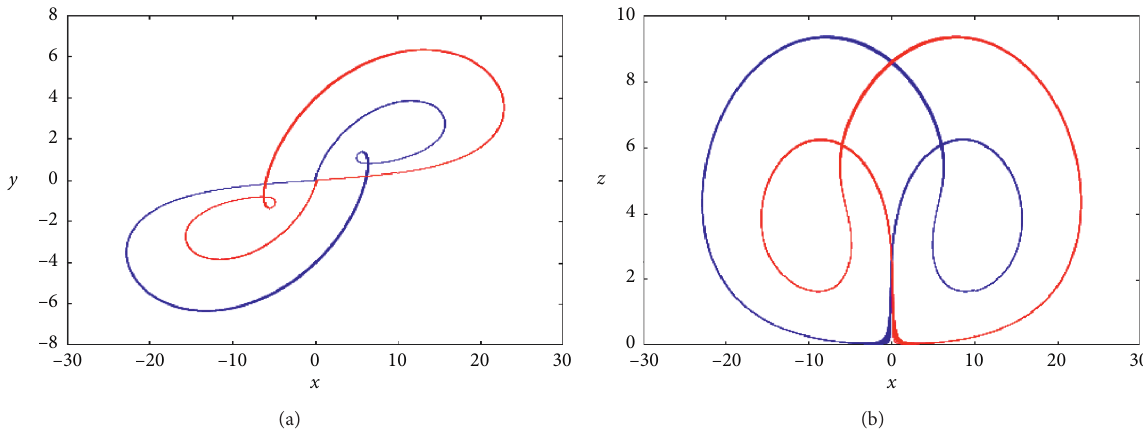
Figure 5: Phase portraits of coexisting limit cycle attractors in (a) x − y and (b) x − z planes (the blue one starts from initial conditions ( 1 , 0 , 0 , 26 ) and the red one starts from ( 1 , 0 , 0 , − 26 ) ).